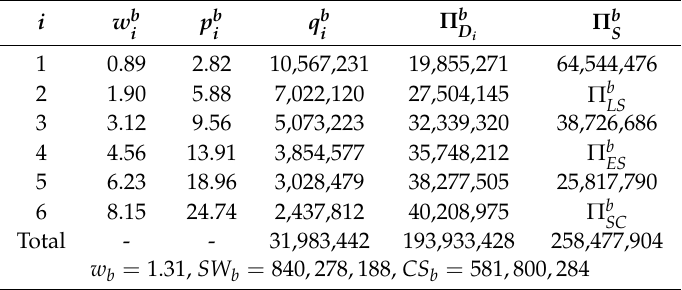
Table 4. BenchmarkNumericalAnalysisResultsofIBWTSupplyChainEquilibriumwithoutRamseypricing.